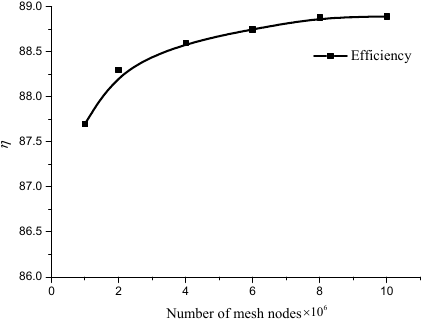
Figure 5. Results of grid independence. Table 4. Mesh details for each domain.